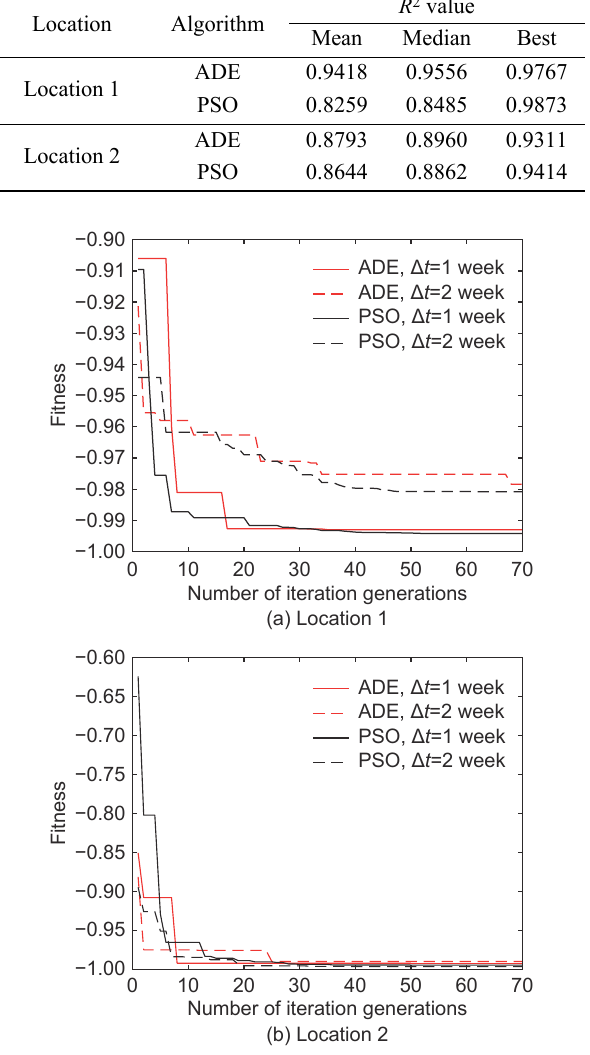
Fig. 4 Fitness vs. iteration generation for best